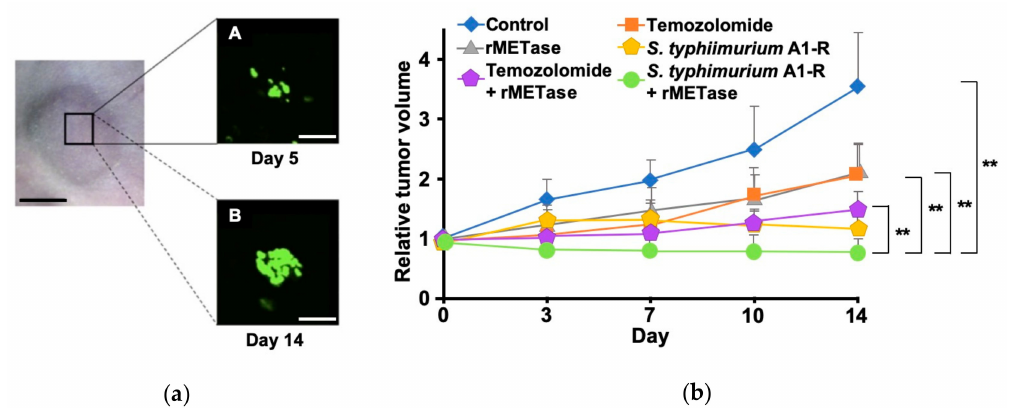
Figure 6. Combination therapy oral administration of recombinant methioninase (o-rMETase) and S. typhimurium A1-R. ( a ) Fluorescence imaging of S. typhimurium A1-R-GFP cultured from the melanoma patient-derived orthotopic xenograft (PDOX). ( b ) Comparison of treatment. ** p < 0.01, error bars